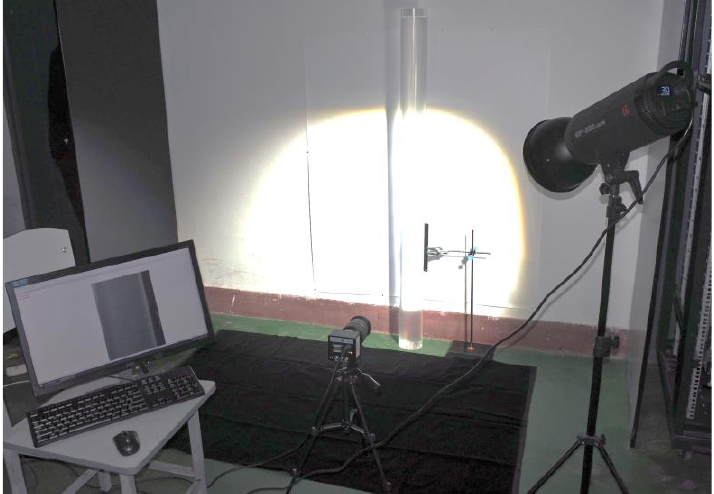
Figure 2. Schematic diagram of the experimental device for particle settlement.